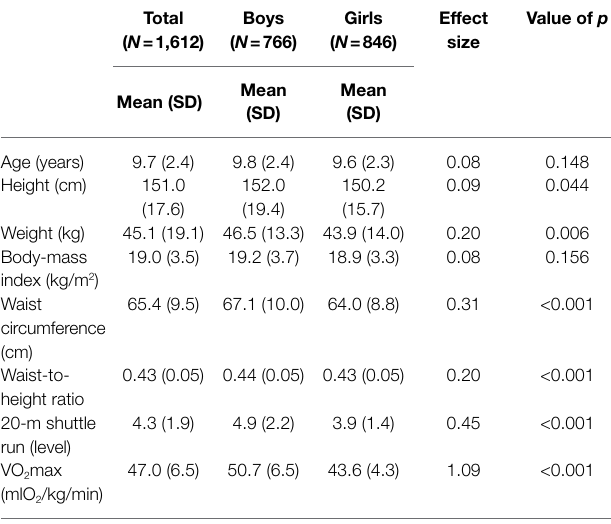
TABLE 1 | Basic descriptive statistics of the study participants ( N =